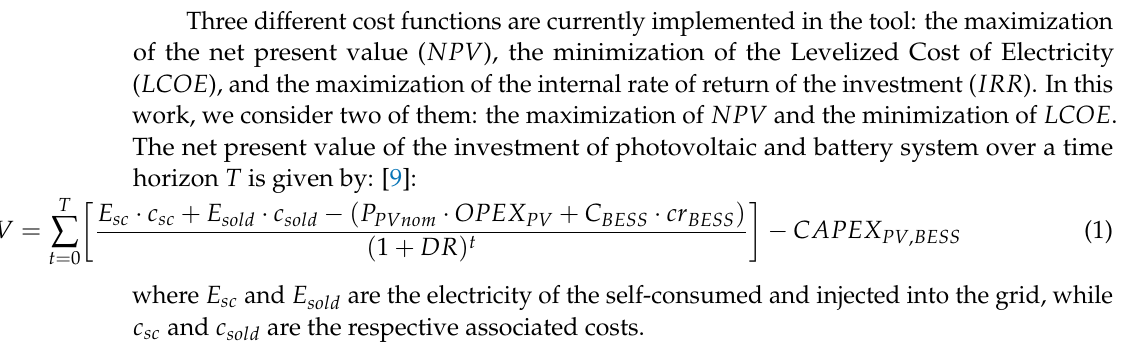
Figure 1. Plot of the reward function obtained optimizing the system capacity considering Scenario